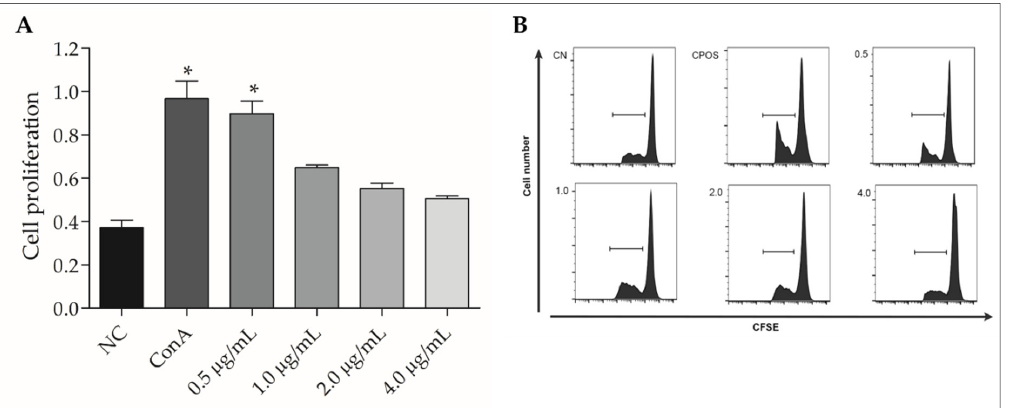
Figure 6. Lymphoproliferation assay of bovine peripheral blood mononuclear cells (PBMCs) stimulated with 0.5, 1.0, 2.0, and 4.0 μ g/mL recombinant GUDIV-103 (rGUDIV-103) antigen. ( A ) rGUDIV-103 stimulated cell division index. X-axis includes the different antigen concentrations, the negative control (NC; PBS 1X, pH 7.4), and positive control (concanavalin A, ConA). Statistical significance ( p < 0.05) is represented using *. ( B ) Detection of lymphocyte division using fluorescence intensity. The arrow above 5(6)-carboxyfluorescein diacetate succinimidyl ester (CFSE) represents its emission spectrum, with the horizontal line indicating the region (peak area) analysed. Treatments were compared using the Kruskal – Wallis non-parametric test, followed by Dunn’s post hoc test. Data are expressed as the mean ± standard deviation (n = 9). * p < 0.05 vs negative group. The expression of the pro-apoptotic caspase-3 gene in PBMCs treated with 1.0, 2.0, and 4.0 μ g/mL rGUDIV-103 for 2 h was not significantly different from that seen in the NC group (data not shown). However, caspase-3 expression increased in a dose- dependent manner after incubation for 6 h (Figure 7).